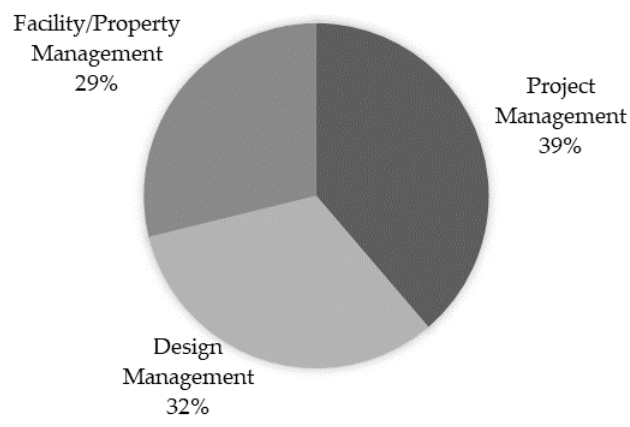
Figure 3. Information of respondents.